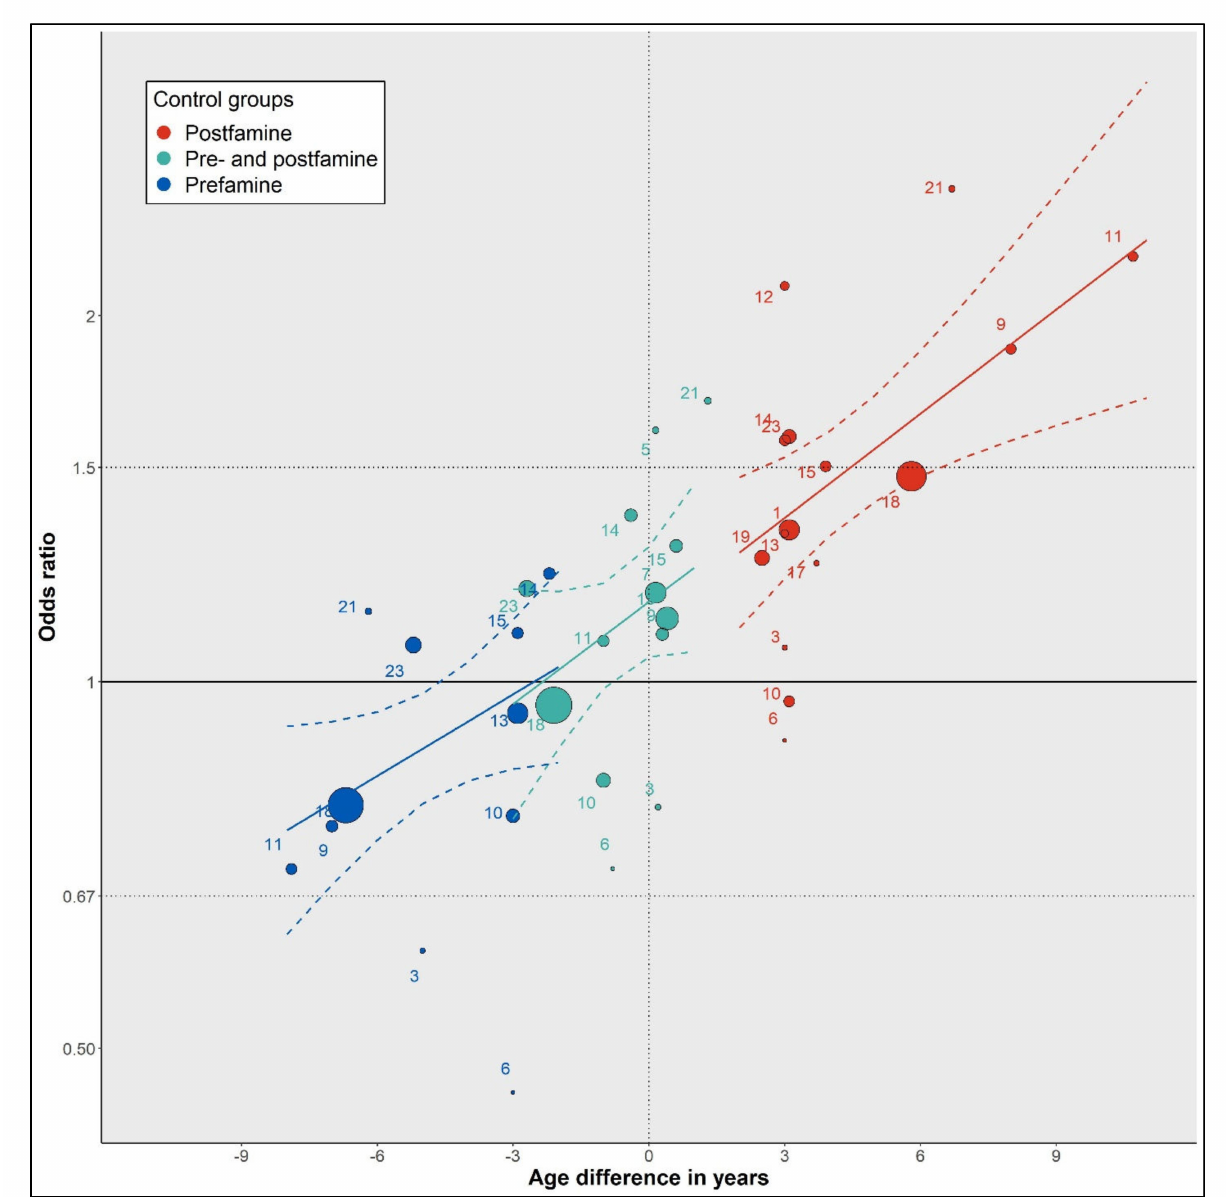
Figure 4. Meta-regression analysis of famine effect estimates over age differences between famine births and different control groups. The size of each dot is proportional to the weight of the study. The dashed colored lines represent the 95% CI for each meta-regression